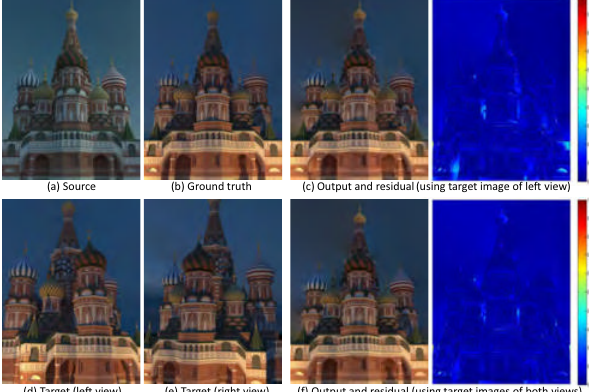
Fig. 6 We test our lighting transfer methods on a synthetic dataset, and show results of a quantitative evaluation. Compared with output using only the left-view target image (c), the output image produced with both target images (f) looks more similar to the ground truth (b) and has smaller residuals.